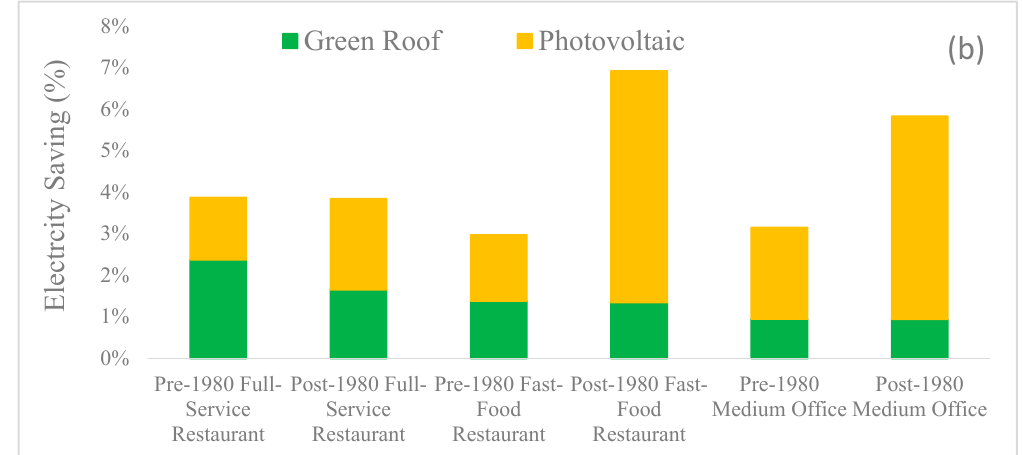
Figure 6. Percentage (%) of annual electricity savings from the integration of green roofs and photovoltaic systems compared with traditional roofs under the A1F1 emission scenario in 2050: ( a ) Glendale; ( b ) Koreatown. Table 4. Relative change (%) in annual total energy demand between 2050 and present (1991–2005) in all tested buildings under A1F1 emission scenario.